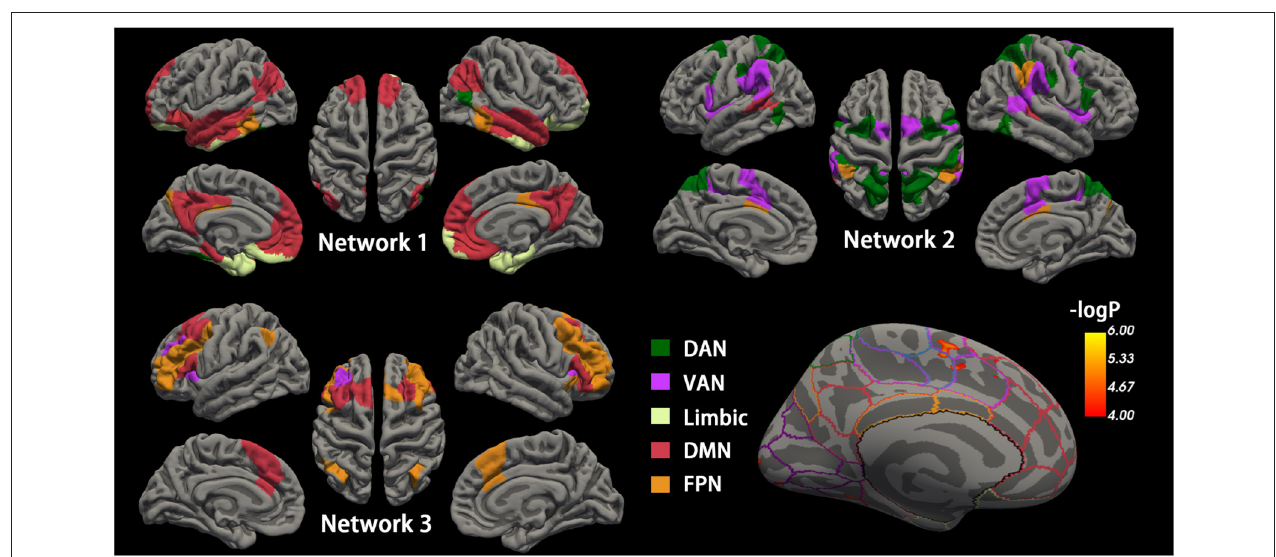
FIGURE 2 | Cortical networks during the maintenance phase and accuracy-related neural activation. Top-left, top-right, and bottom-left cortical mappings illustrated the nodes of the three empirical networks identified by the community detection algorithm during the maintenance phase, colored by a priori network assignments from the Schaefer cortical parcellation. Network 1 is mainly composed of the DMN and limbic network, and Network 2 consists of DMN and FPN. Network 3 generally includes DAN and VAN. The bottom right shows the surface maps of the activated cortex in the retrieval phases related to accuracy. The border on the surface indicates the network identical to the above Schaefer cortical parcellation. The activation is observed in the region of VAN. DMN, default mode network; FPN, frontoparietal network; DAN, dorsal attention network; VAN, ventral attention network.